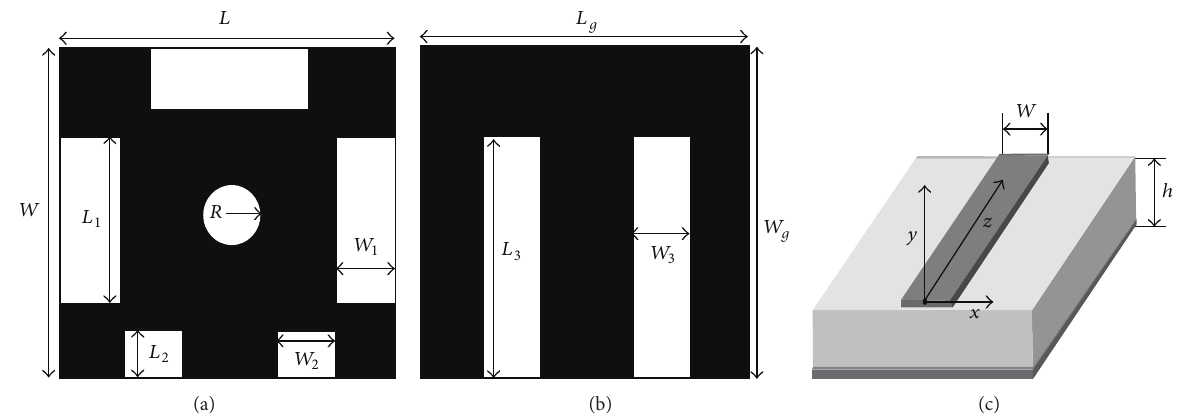
Figure 1: Proposed antenna: (a) top view, (b) bottom view, and (c) microstrip transmission